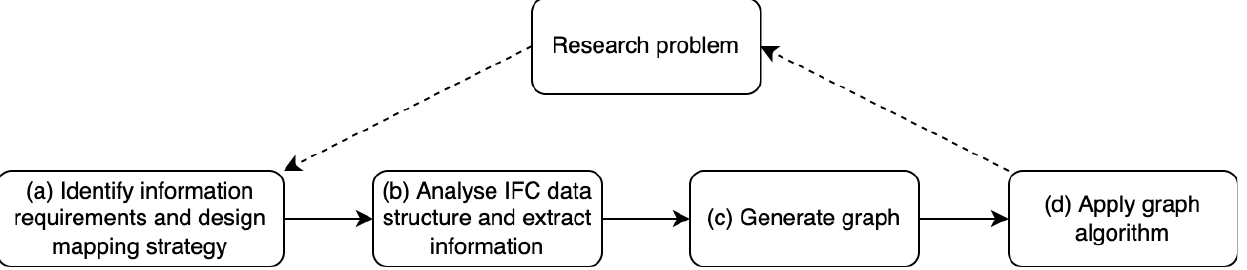
Figure 6. The basic pattern for IFC-to-graph conversion.